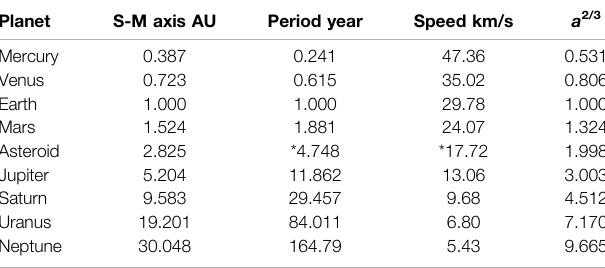
TABLE2| Thesemi-majoraxes a ,siderealperiod T andmeanorbitalvelocities v of the planets of the Solar System, including the belt of the asteroids located between Mars and Jupiter. Asteroid refers to the 5:2 Kirkwood asteroid-belt gap; (*) indicates theoretical values calculated using Eq. 1 . The last column reports the values of a 2/3 discussed in the main text. (Data from: https://nssdc.gsfc.nasa.